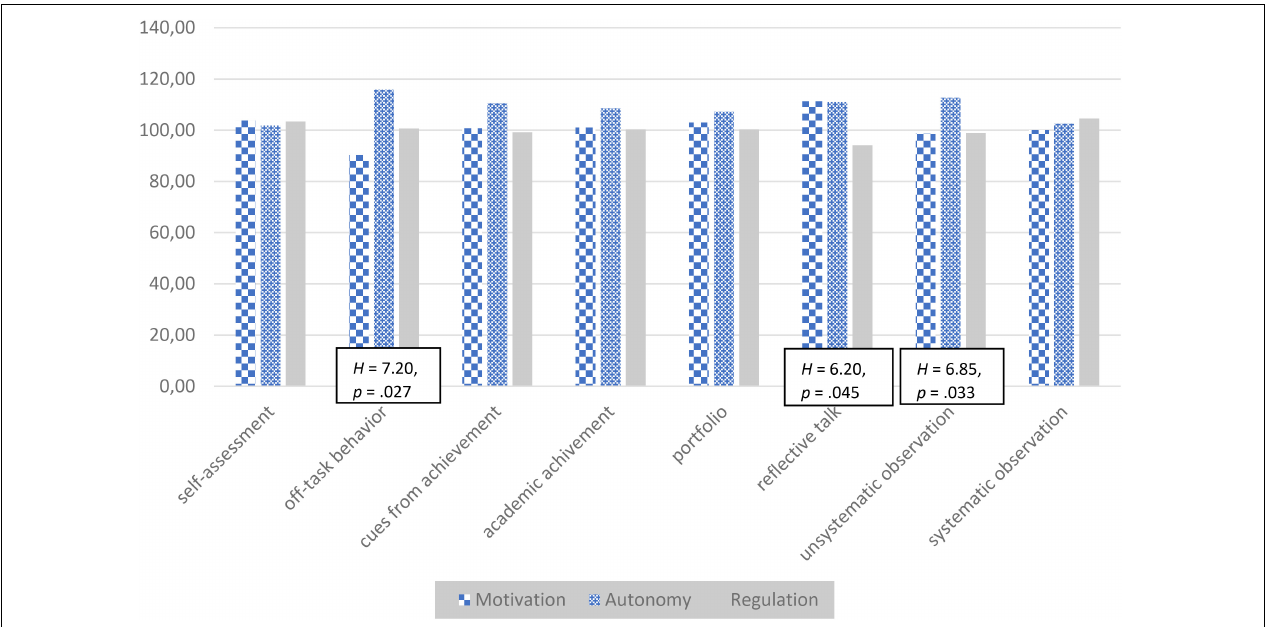
TABLE 6 | Spearman correlations between codes of SRL conceptualization and codes of ideas about SRL assessment, r ( p ). Self-ass. Off-task Strat. hint Achiev. Reflective Portfolio Unsystem. Cognitive